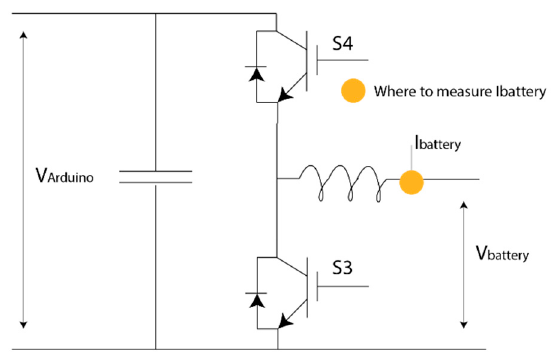
Figure 6. Electric circuit for the battery to provide the power to the Arduino bus.